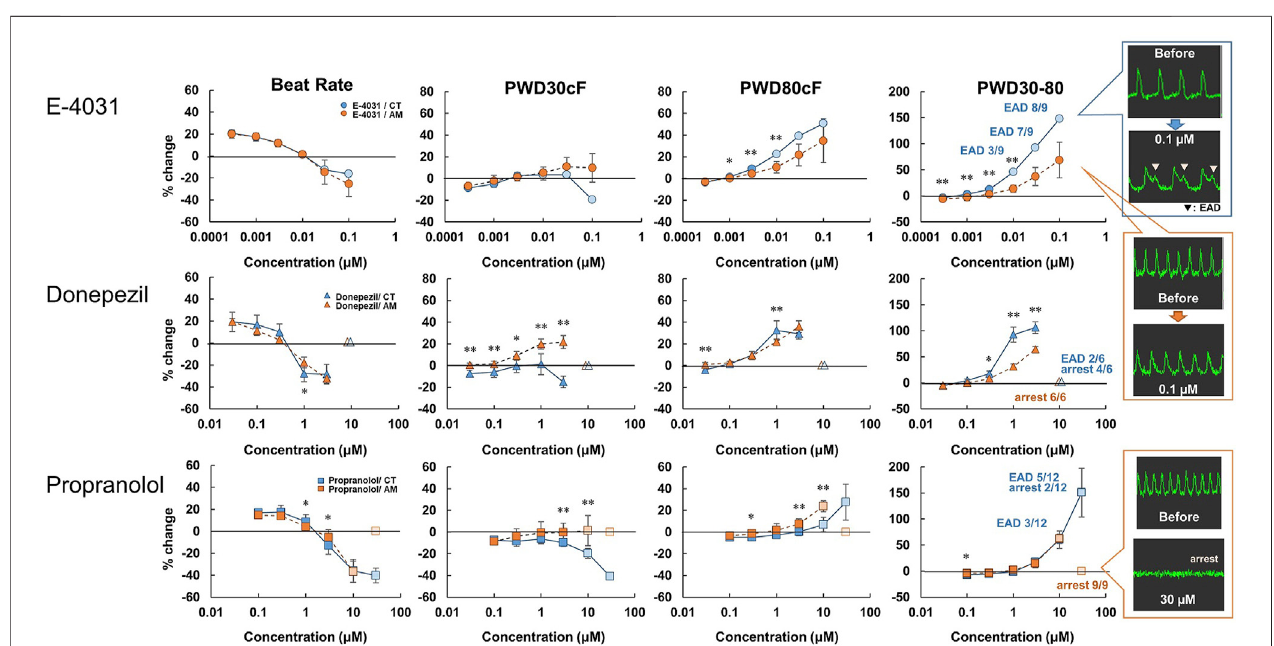
FIGURE 3 | Dose-response of I Kr blockers in CT and AM. CT and AM were treated with various concentrations of E-4031, donepezil, and propranolol, and membrane potential (MP) was analyzed by FDSS/ μ Cell imaging platform. Y -axis represents the percentage change from the value before test compound